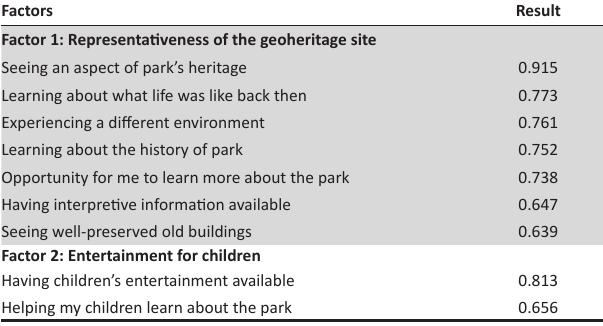
TABLE 4: Factor analysis for visitors’ attributes towards geotourism. Factors